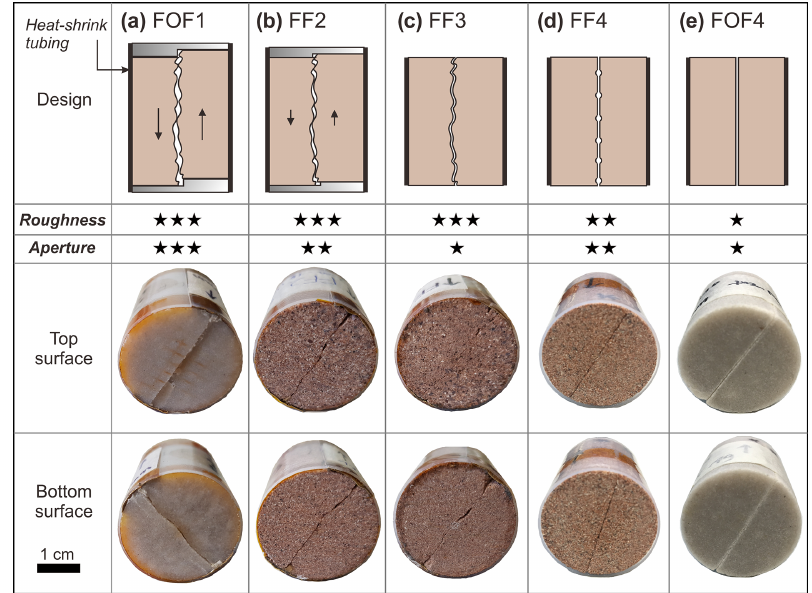
Figure 1. Fracture configurations used in this study and strategy of sample preparation. The number of stars qualitatively indicates the relative intensity of surface roughness and fracture aperture. The top and bottom sample surfaces were used for the measurements of the mechanical aperture. (a) FOF1, tensile fracture with a pre-offset of 0.75mm along the sample axis; (b) FF2, tensile fracture with a pre-offset of 0.2mm; (c) FF3, matched tensile fracture; (d) FF4, saw-cut rough fracture; (e) FOF4, saw-cut smooth